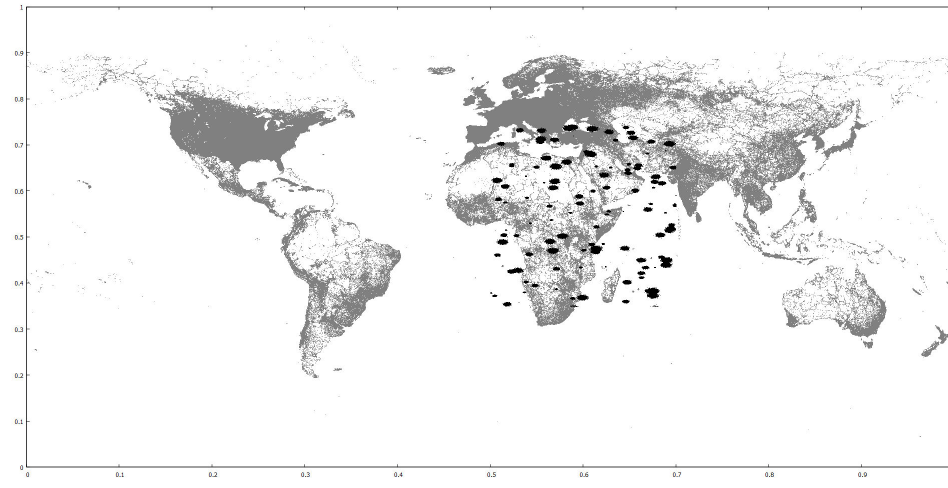
Figure 6. Road networks (gray) and synthetic 706,000 (black) datasets. The circle has its center on the query centroid, and its radius is calculated from the right member of the Heuristic 1 inequality. The rounded rectangle’s perimeter has a distance from the query MBR equal to the right member of the Heuristic 2